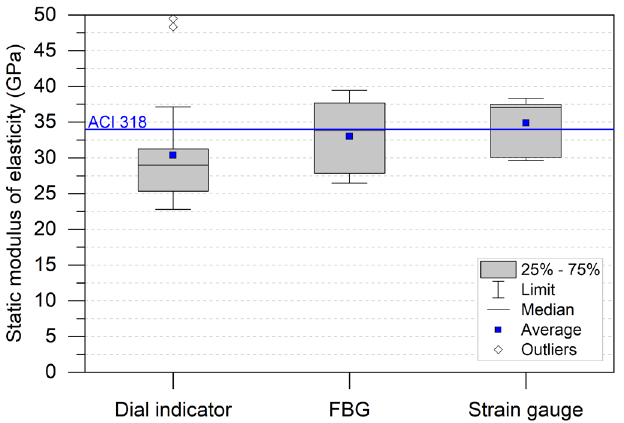
Figure 10. Static elastic modulus of the mortar